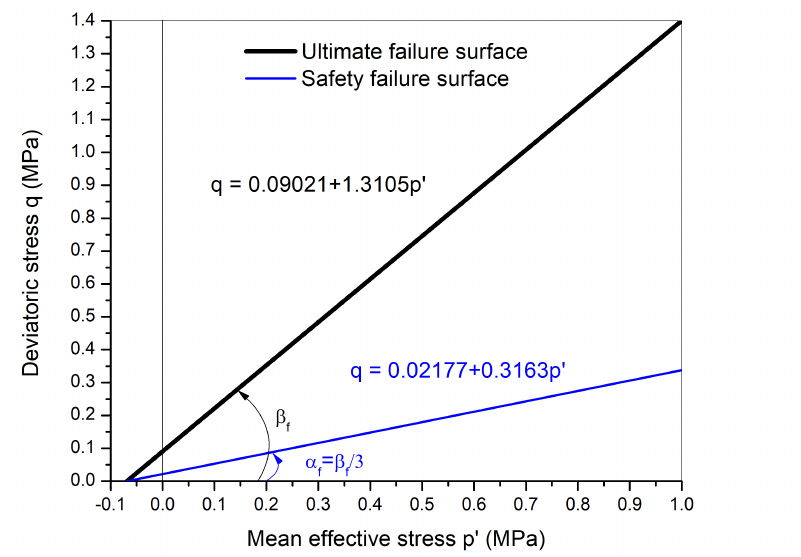
Figure 8. The ultimate failure envelope and safety failure envelope in p (cid:48) - q plane.